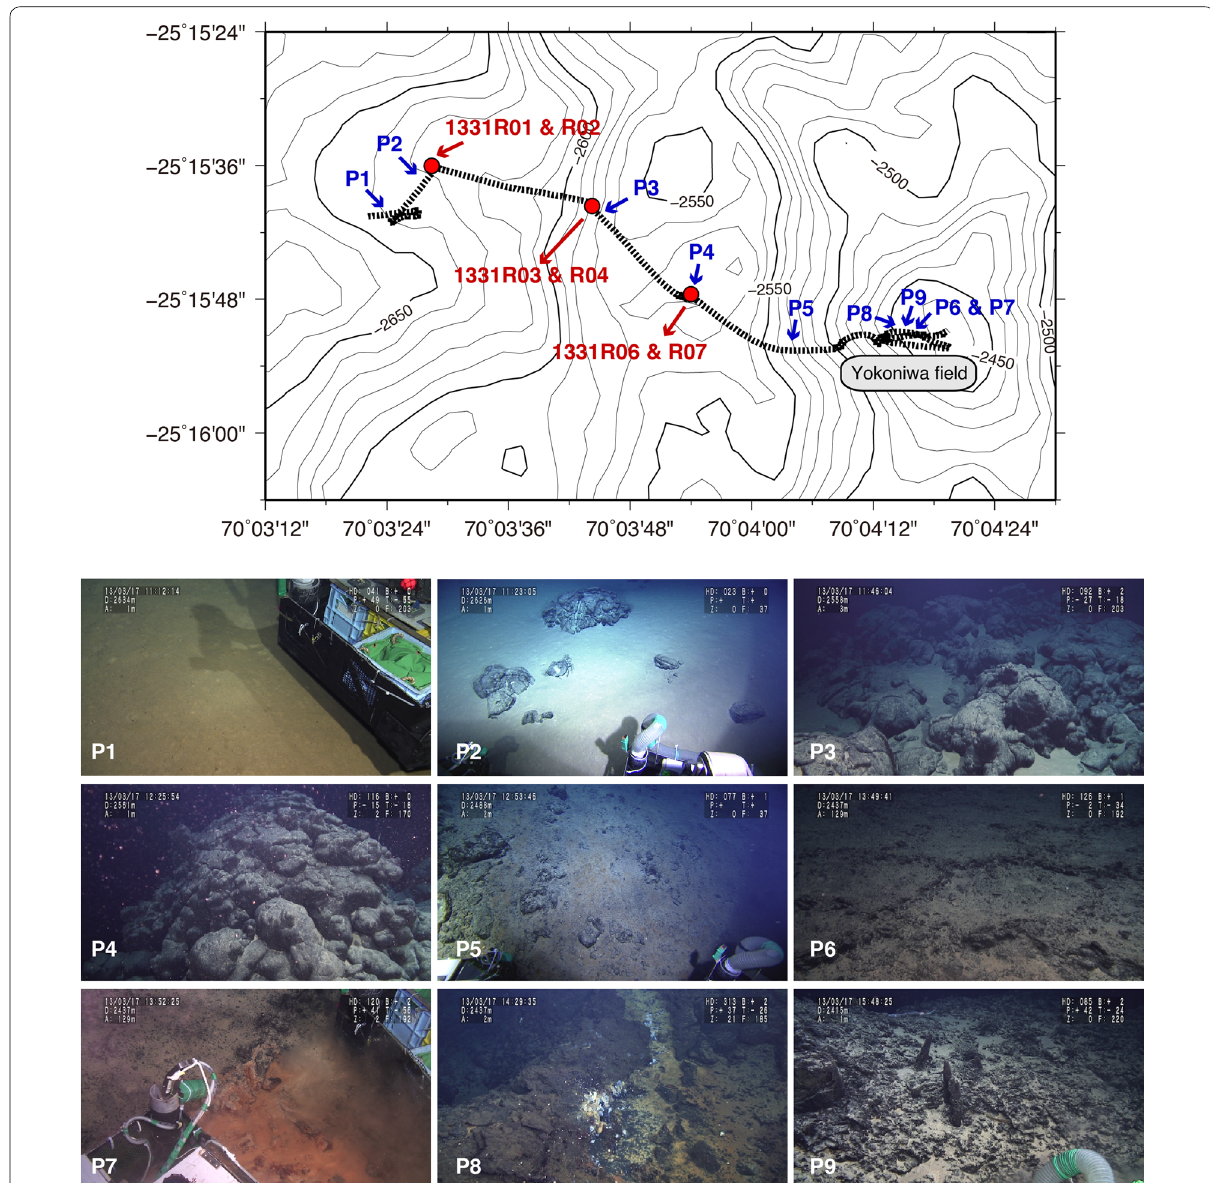
Fig. 6 Seafloor surface geological signatures along the dive track of 6K#1331 (dive observer: T. Sato). Magnetic and physical properties for lava samples of 1331R01, 1331R02, 1331R03, 1331R04, 1331R06, and 1331R07 are shown in Table 1 and Additional file 4: Figure